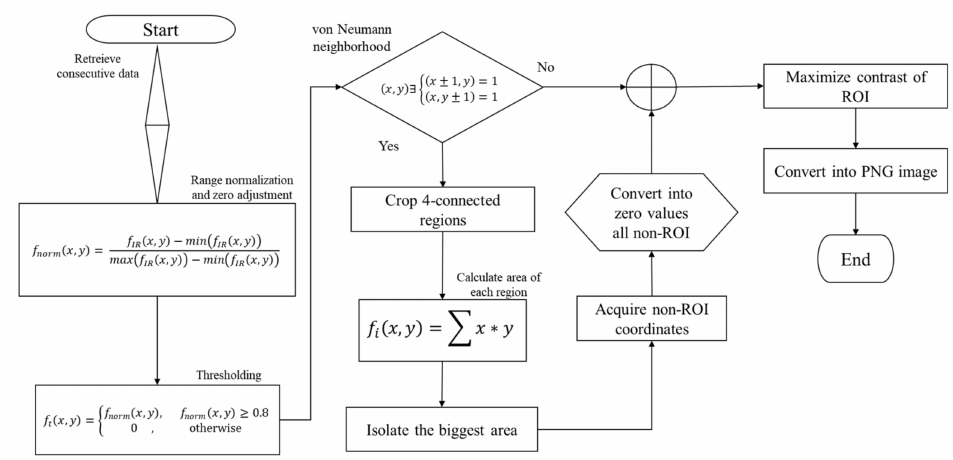
Figure 6. Flowchart of the radiometric data processing to obtain a segmented IR image, without interferences or non- desirable